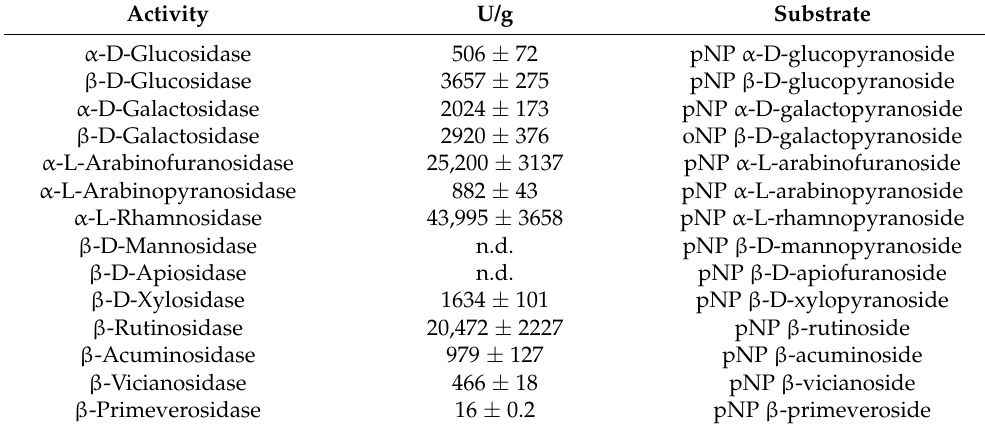
Table 1. Glycosidase activities in Aromase